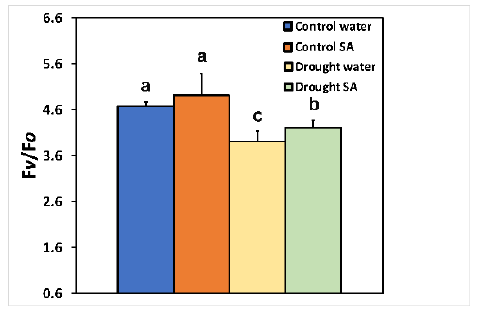
Figure 5. The efficiency of the oxygen evolving complex (OEC, F v /F o ) of oregano seedlings grown under optimal conditions (control) or moderate drought stress (MoDS) and sprayed with 1 mM SA or H 2 O. Error bars represent standard deviations ( n = 4). Different lowercase letters represent statistical difference ( p < 0.05).